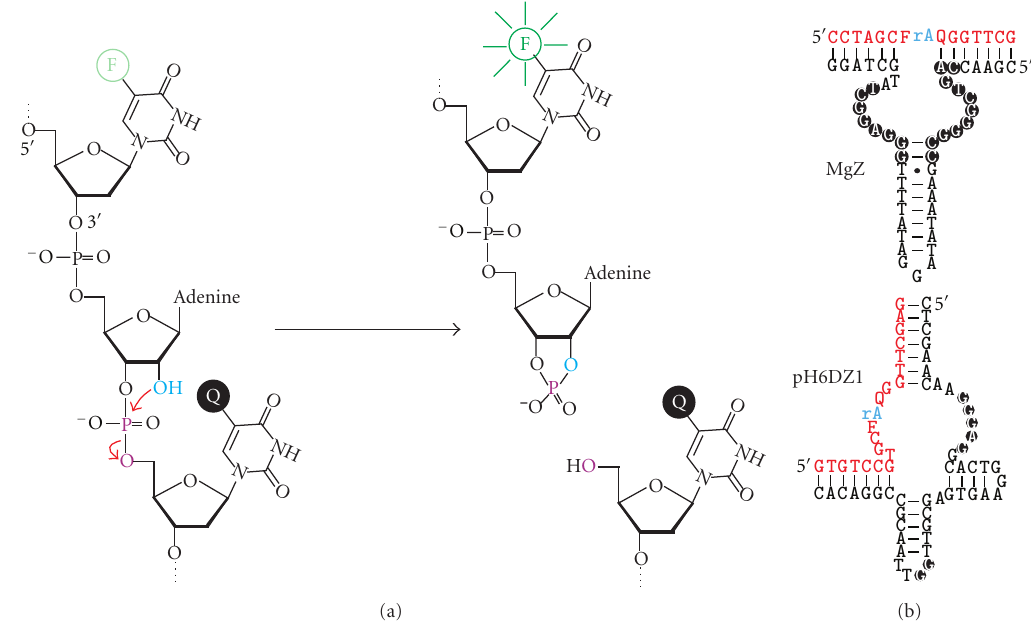
Figure 5: Fluorogenic DNAzymes obtained from random-sequence DNA libraries. (a) The chemical transformation catalyzed by these DNAzymes. These DNAzymes cleave a phosphodiester bond using a nearby 2 (cid:2) -hydroxyl (light blue) as the nucleophile. The special nucleic acid substrate to be cleaved has two features: (1) it contains a single ribonucleotide (riboA) as the cleavage site embedded in a DNA sequence, and (2) the cleavage site is immediately sandwiched between two DNA nucleotides modified with a fluorophore (F; specifically fluorescein) and a quencher (Q; specifically DABCYL). (b) Secondary structures of two representative signaling DNAzymes. rA: adenine ribonucleotide (the cleavage site; shown in blue); F, fluorescein-modified dT; Q, DABCYL-modified dT. Conserved nucleotides are shown in black circles. The substrate strands are shown in